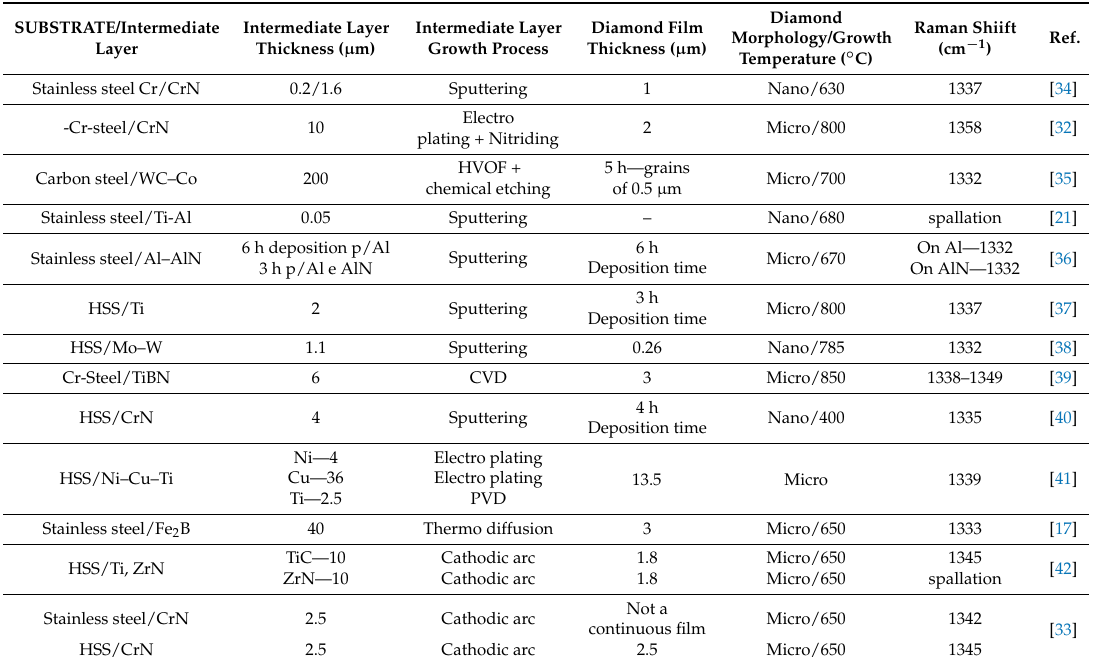
Table 1. Diamond films on steel substrates found in the